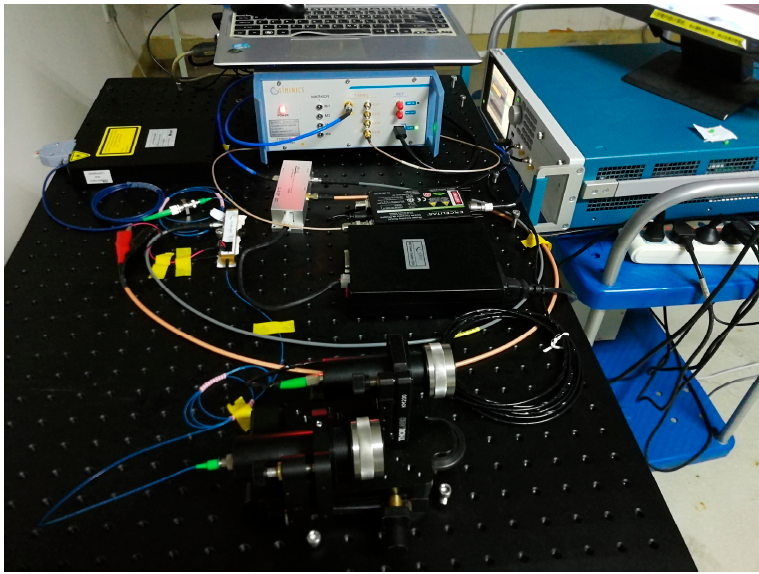
Figure 8. Experiment platform for the modulation-encoded PSPCR Lidar and the traditional PSPCR Lidar.